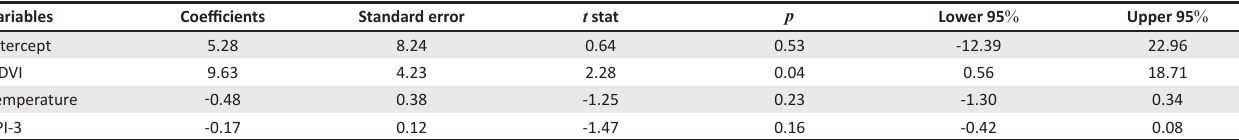
TABLE 4c: Summary of outputs. Variables Coefficients